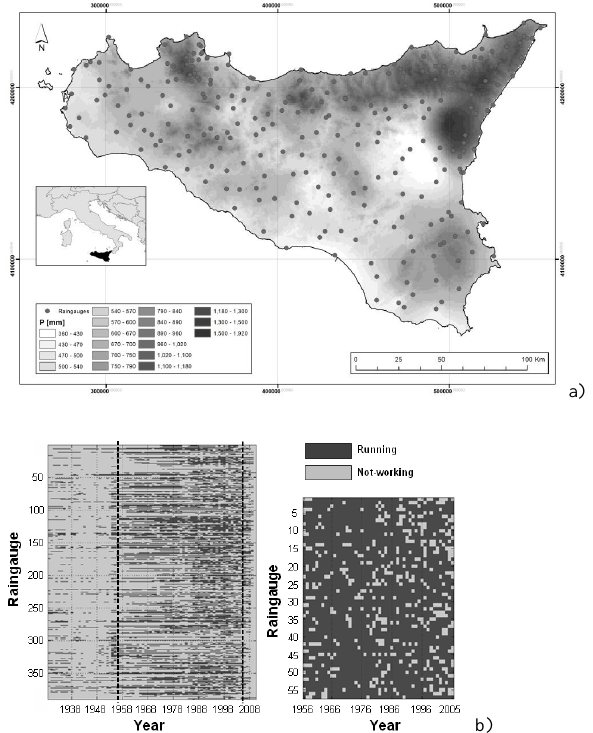
Fig. 1. Location of rain gauge stations over the region and spa- Figure 1. Location of raingauge stations over the Region and spatial distribution of mean 5 tial distribution of mean annual rainfall depth, from Di Piazza et al. (2011) ( a ). The running and the intermittently recording rain annual rainfall depth, from Di Piazza et al. (2011) (a). The running and the not-working (i.e. 6 gauges over the entire period of observation (1929–2009) ( b , on the intermittently recording) raingauges over the entire period of observation (1929-2009) (b, on 7 left) and selected dataset, i.e., stations (57) and time of observation the left) and selected dataset, i.e. stations (57) and time of observation (1956-2005) (b, on the 8 (1956–2005) ( b , on the right). Data are from the regional database right). Data are from the regional database published by Osservatorio delle Acque – Agenzia 9 published by Osservatorio delle Acque – Agenzia Regionale per i Regionale per i Rifiuti e le Acque (OA-ARRA). 10 Rifiuti e le Acque (OA-ARRA).